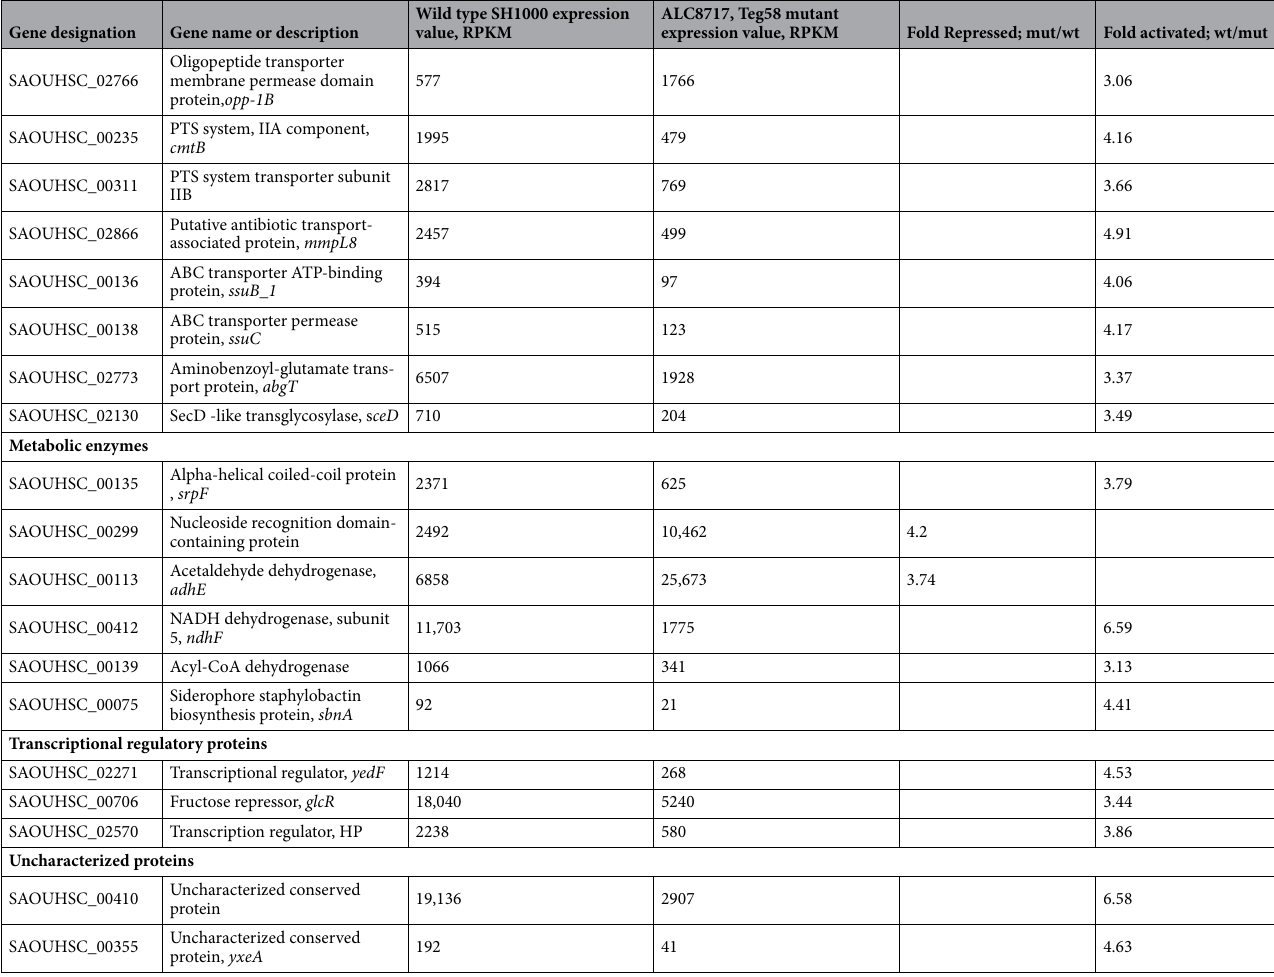
Table 1. Selected teg58 -regulated